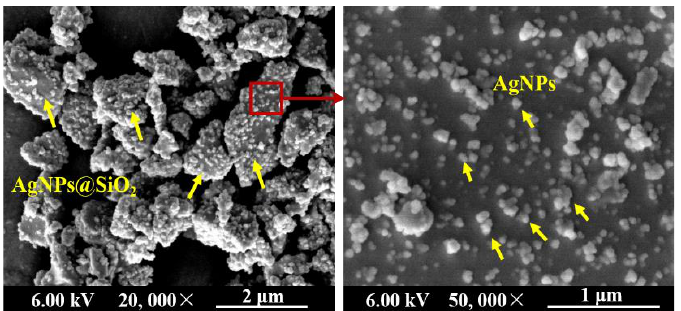
Figure 1. Micromorphology of the commercial AgNPs@SiO 2 antibacterial particles under the magnification of 20,000× and 50,000×.